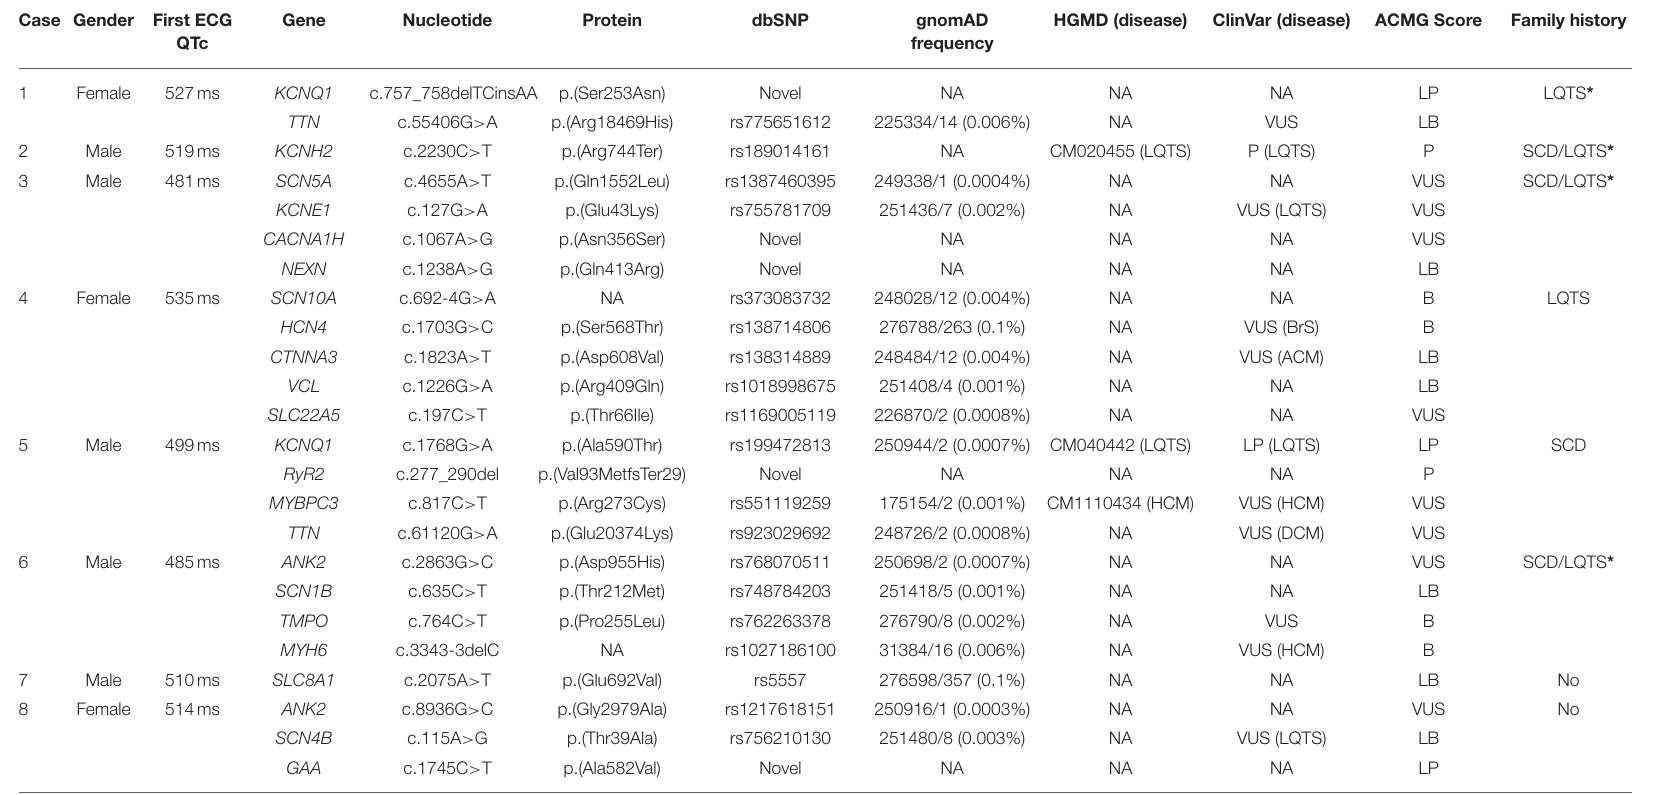
TABLE 2 | Genetic data of variants